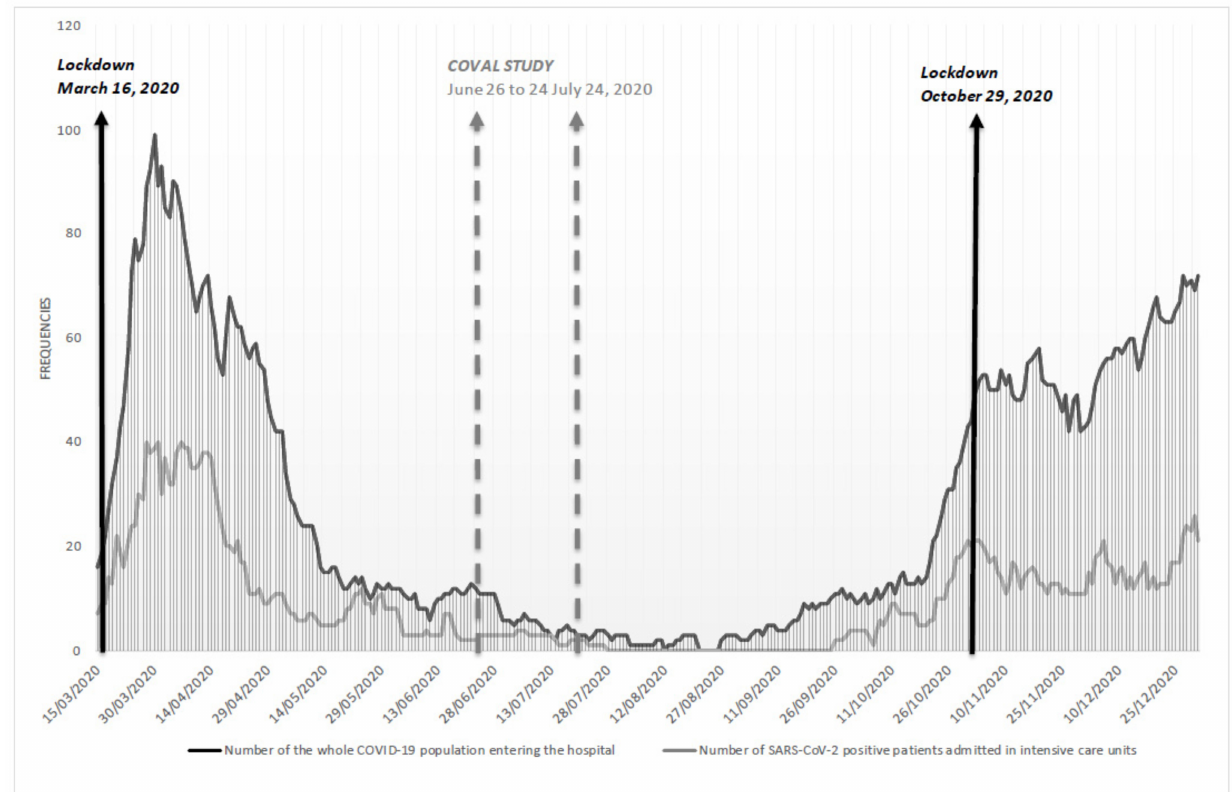
Figure 5. Number of SARS-CoV-2 positive patients from the Grand Nancy metropolitan at the Nancy University Hospital between 15 March and 31 December 2020 (black: all, grey: intensive care